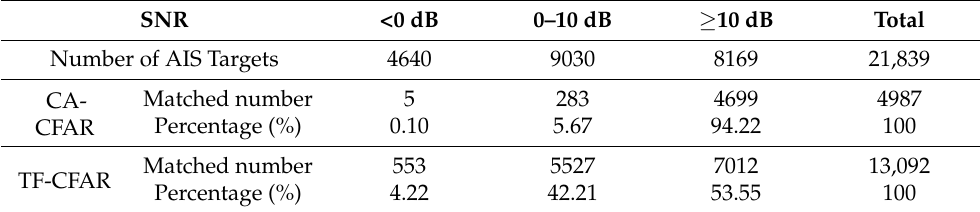
Table 2. The percentage of matched targets under different SNR on 25 September